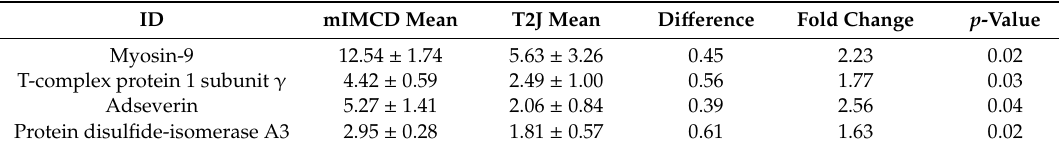
Table 2. Loss of Tsc2 Function is Associated with a Significant Decrease in Four